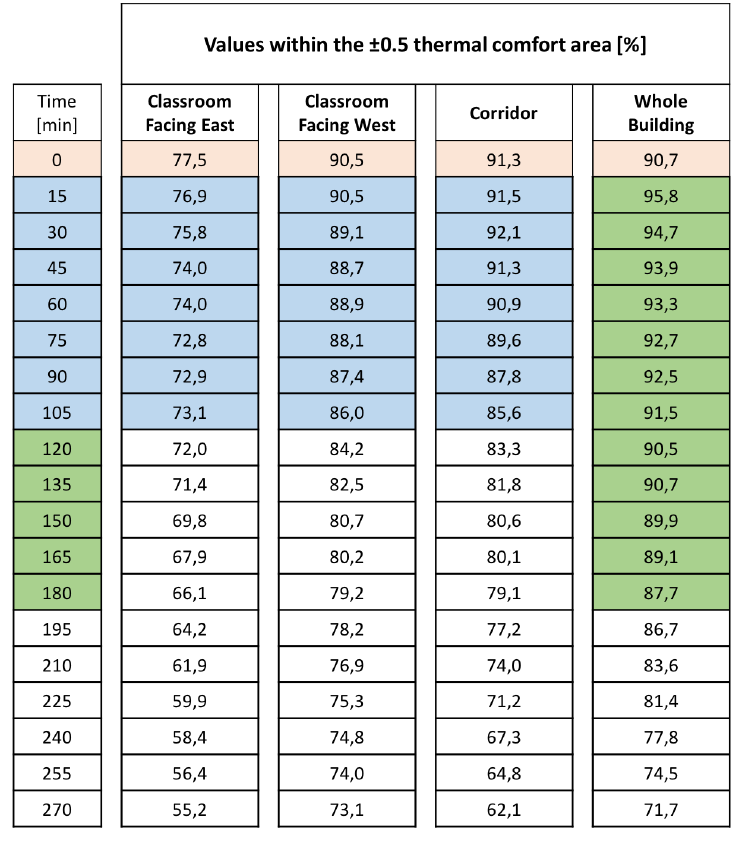
Figure 7. PMV/PPD evaluation on real data: percentage of predicted values within the ± 0.5 thermal comfort area. The first row (in red) represents reference percentages, computed on the observed temperature values. The following rows report percentages computed on the predicted values, at increasing prediction